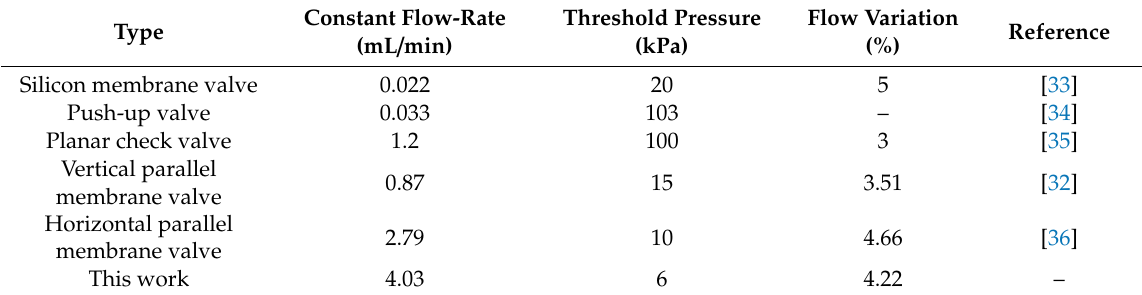
Table 1. Comparison of the di ff erent types of passive flow control